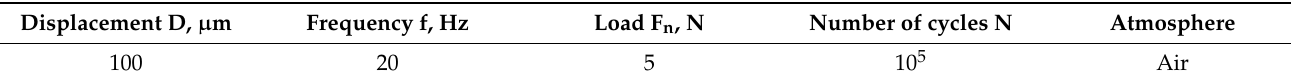
Table 4. Fretting wear tests conditions.